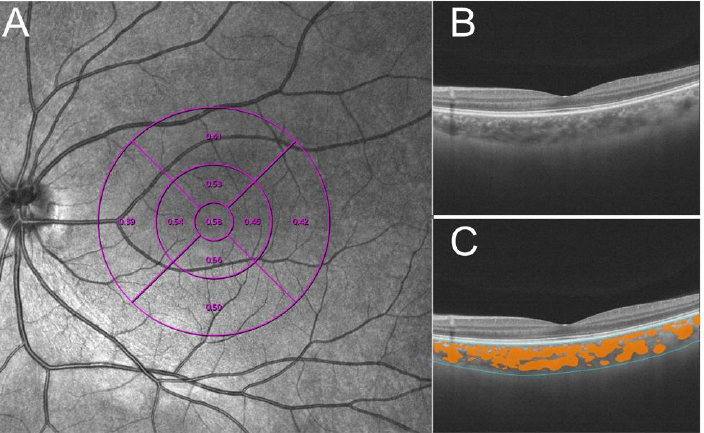
Figure 1. Methods to measure choroidal vascularity index (CVI). ( A ) The ETDRS grid divided the macular region into three concentric rings (1, 3, and 6 mm in diameter [purple lines]). ( B ) Raw image acquired by SS-COT. ( C ) Based on deep learning, the system recognizes the boundary of choroid(blue lines) and identifies the choroid’s large and medium blood vessels (orange zone) and quantifies CVI.